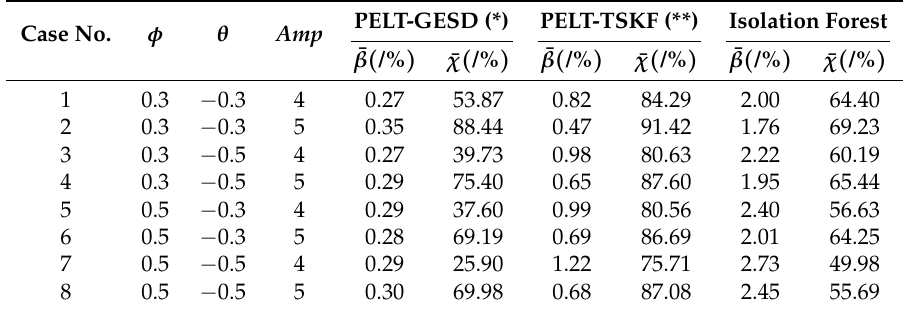
Table 1. Additive outlier detection results for data from autoregressive moving average (ARMA) (1, 1) multistage processes at κ = 5%. Case No. φ θ